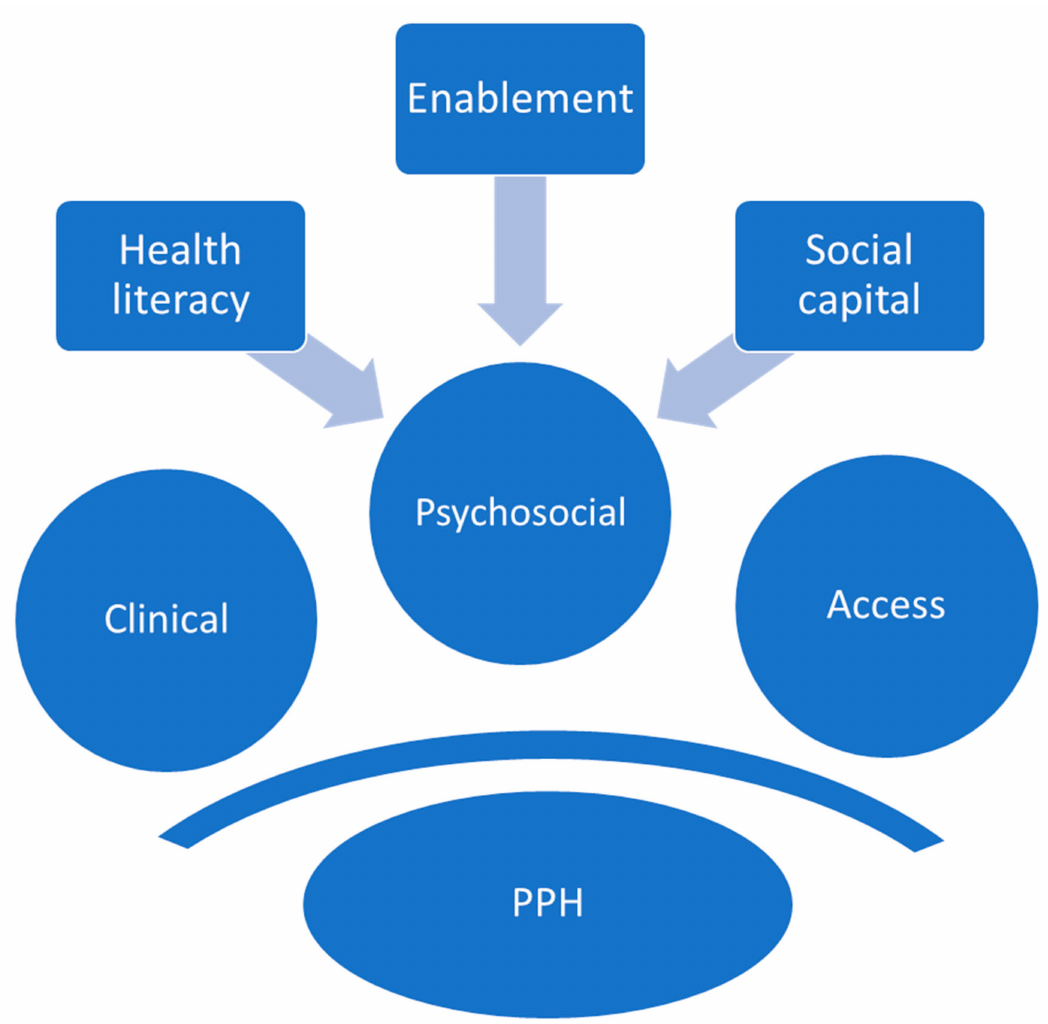
Figure 2. Key psychosocial factors that contribute to PPH for rural-dwelling